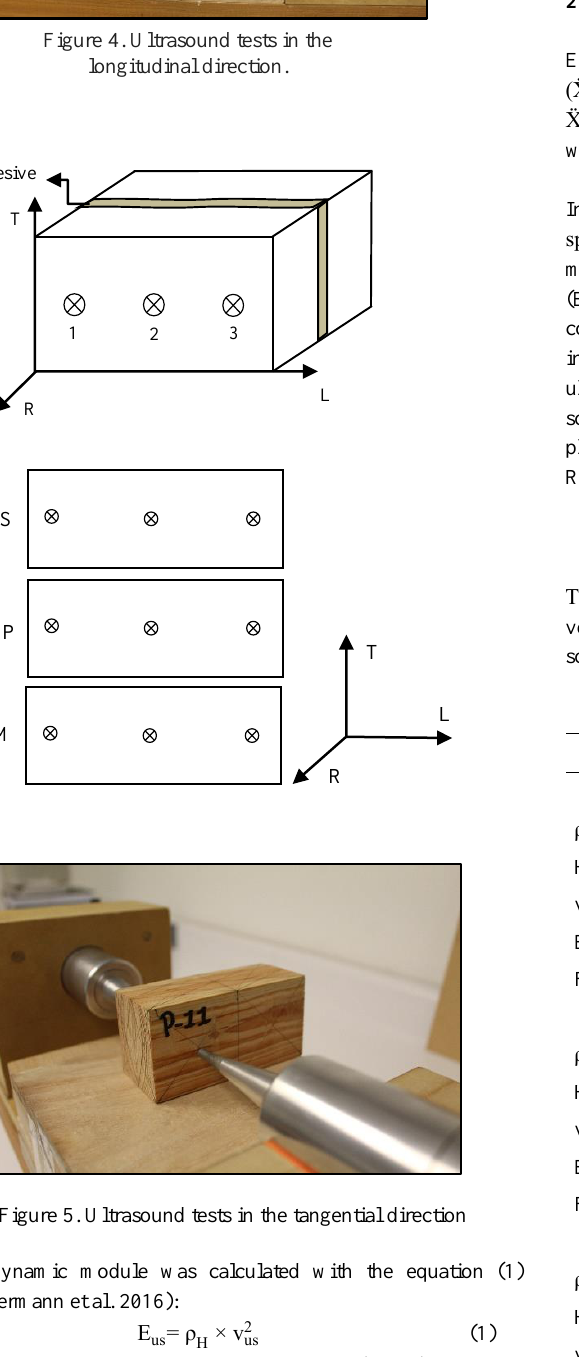
Figure 5. Ultrasound tests in the tangential direction The dynamic module was calculated with the equation (1)